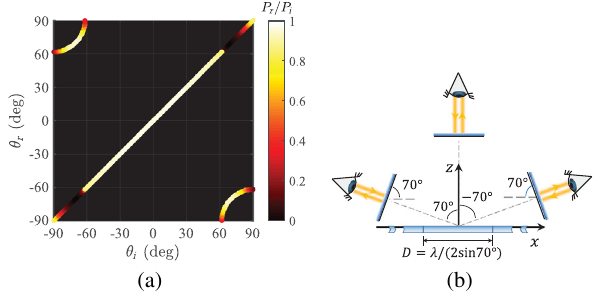
FIG. 6. (a) Simulated results of the three-channel retroreflector made of a patch array. Distribution of the normalized reflected power across Floquet harmonics propagating at different angles θ θ FIG. 7. (a) Illustration of the experimental setup (top view). r versus incident angle i . (b) Appearance of the flat isolating mirror for an external observer. At θ i ¼ 0 ° and θ i ¼ (cid:4) 70 ° angles, Measured reflection efficiency of the metasurface when illumi- nated (b) normally, (c) at angles near θ i ¼ − 70 °, and (d) at angles the observer would see himself as in a mirror normally oriented with respect to him. near θ i ¼ þ 70